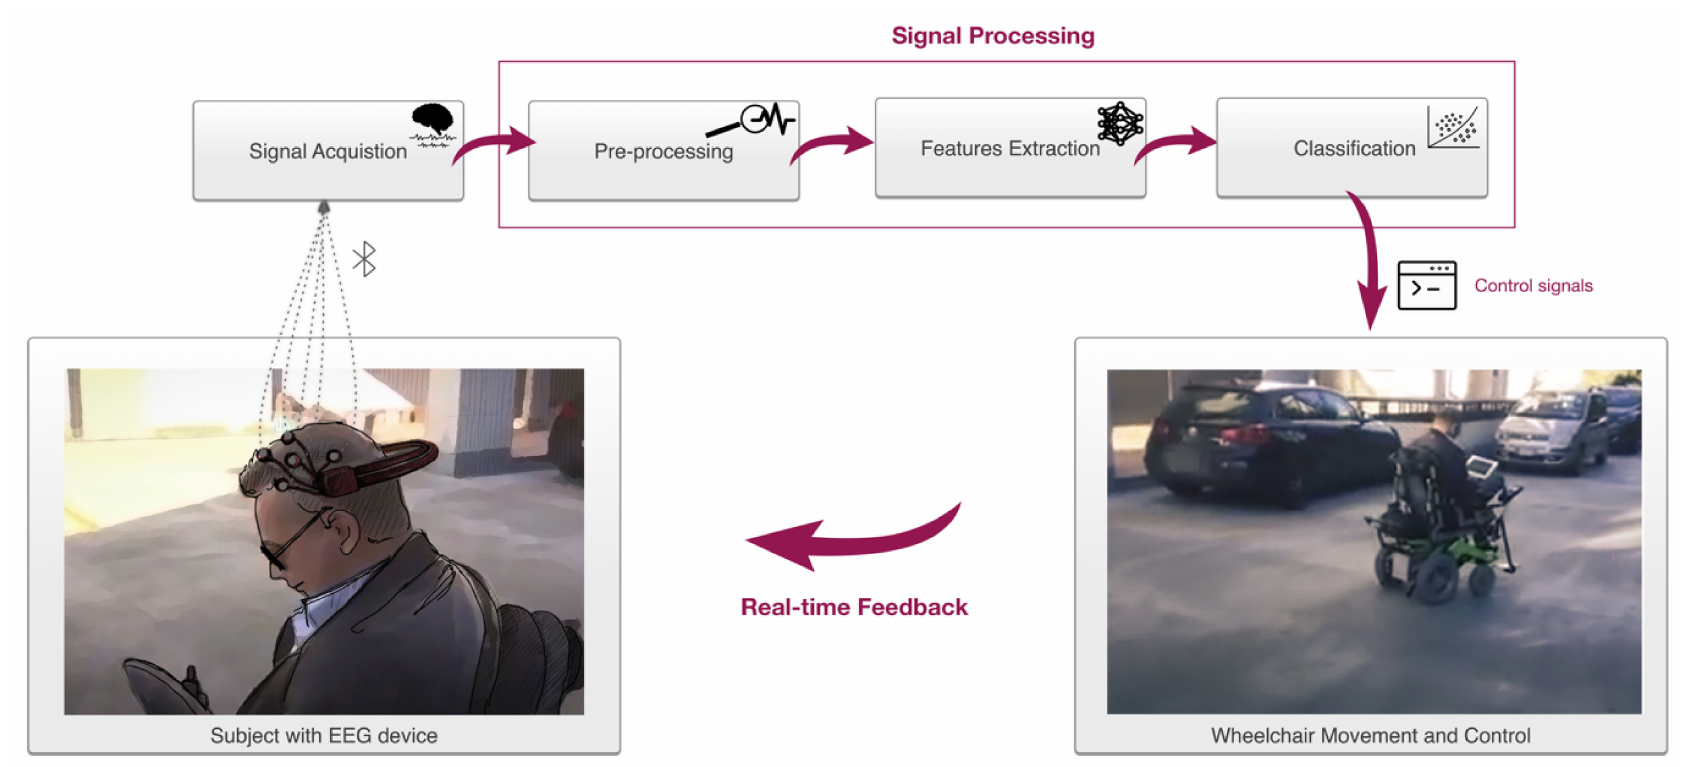
Figure 3. The general architecture of a brain-controlled wheelchair system and application example in a real environment. Reproduced with permission [86,87]. Graphics by